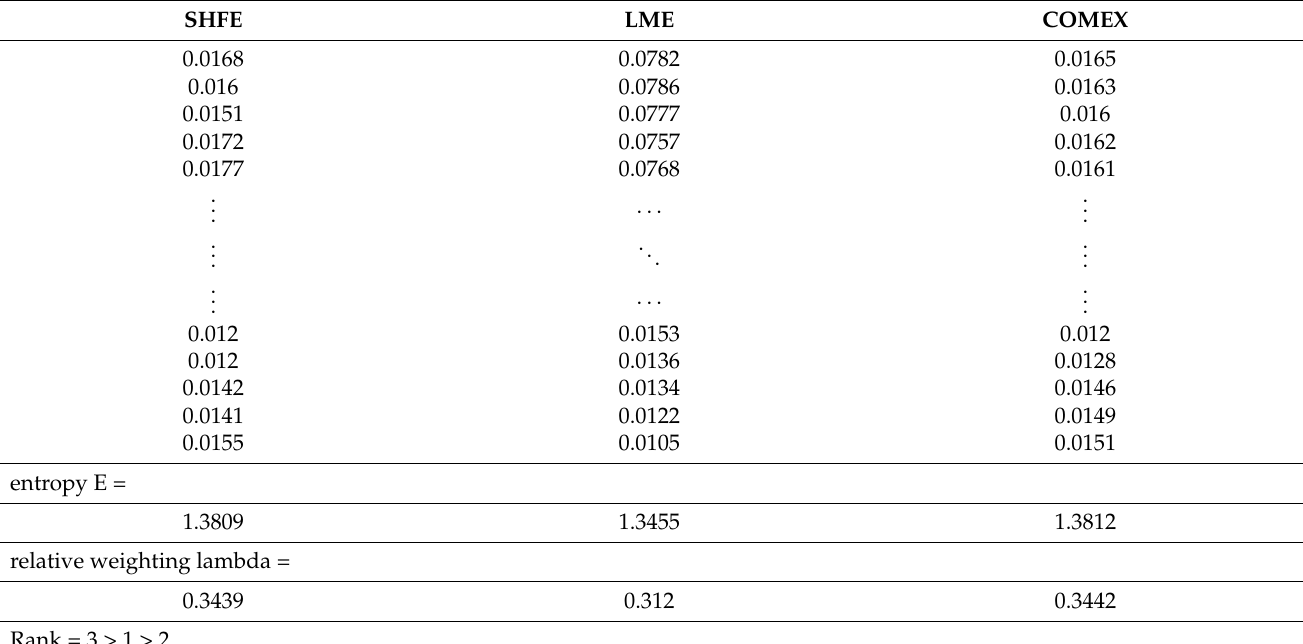
Table 10. Values from the processing of each factor after weighted analysis using grey entropy before the COVID-19